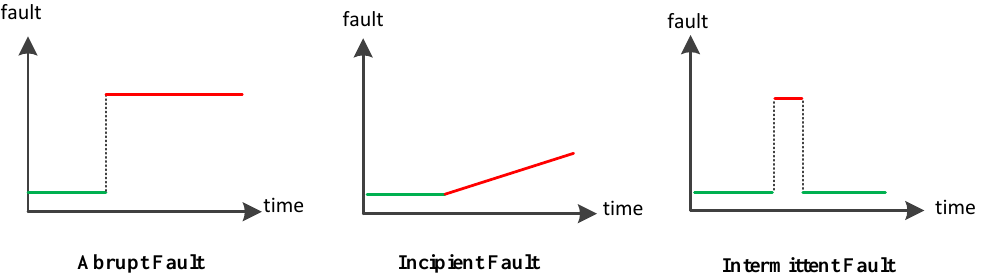
Figure 2. The graphical description of abrupt, incipient, and intermittent